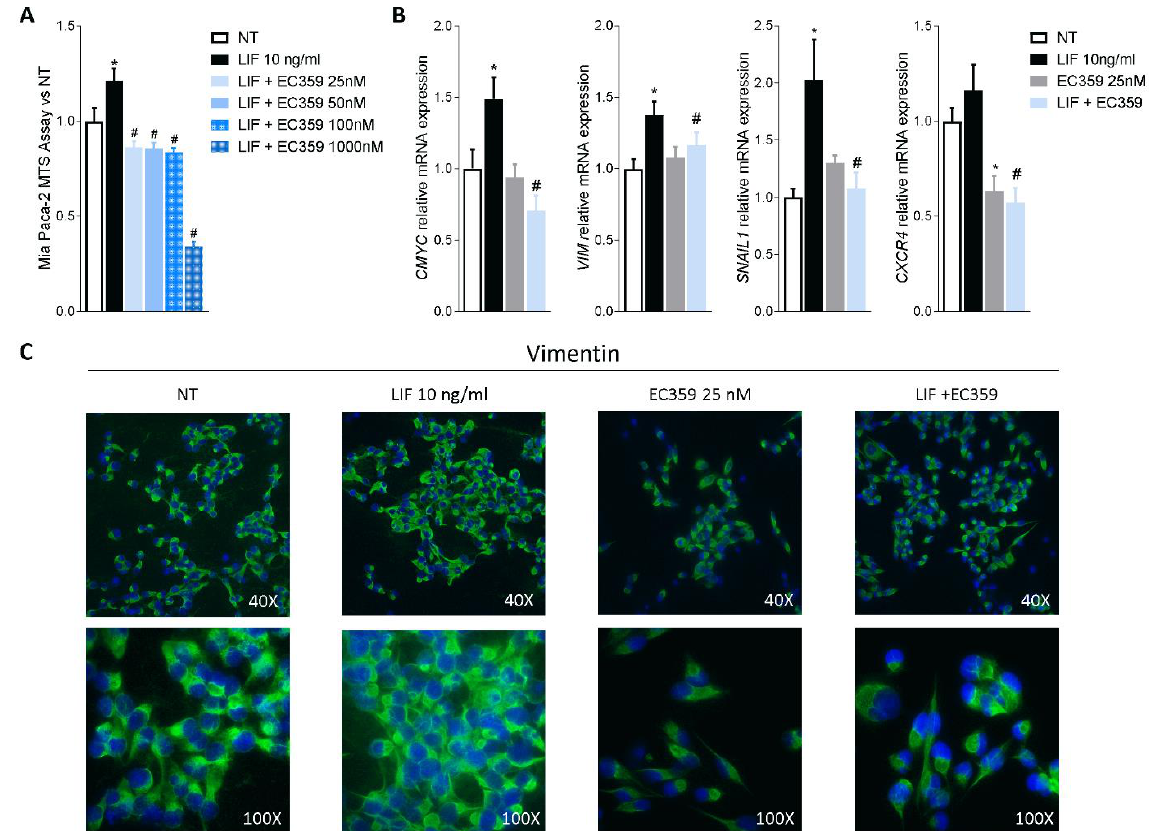
Figure 3. LIFR inhibition reverses pancreatic cancer cell proliferation and EMT process promoted by LIF. MIA PaCa-2 cells were serum-starved and primed with LIF (10 ng/mL) alone or in combination with increasing concentrations of LIFR antagonist, EC359 (25, 50,100, 1000 nM). Data shown are ( A ) dose-response curve of EC359 (25, 50, 100, 1000 nM) determined using MTS assay on cells. Each value is expressed relative to the non-treated (NT) value, which is arbitrarily set to 1. Results are the mean ± SEM of 10 samples per group. ( B ) Relative mRNA expression of the proliferation marker C-Myc ; the EMT markers VIM and SNAIL- 1; and CXCR4 . Each value is normalized to GAPDH and is expressed relative to those of positive controls, which are arbitrarily set to 1. Results are the mean ± SEM of five samples per group (* represents statistical significance versus NT, and # versus LIF, p < 0.05). Panel ( C ) shows changes in vimentin expression assessed by immunofluorescence analysis in MIA PaCa-2 cells triggered with LIF (10 ng/mL) alone or in combination with EC359 25 nM.